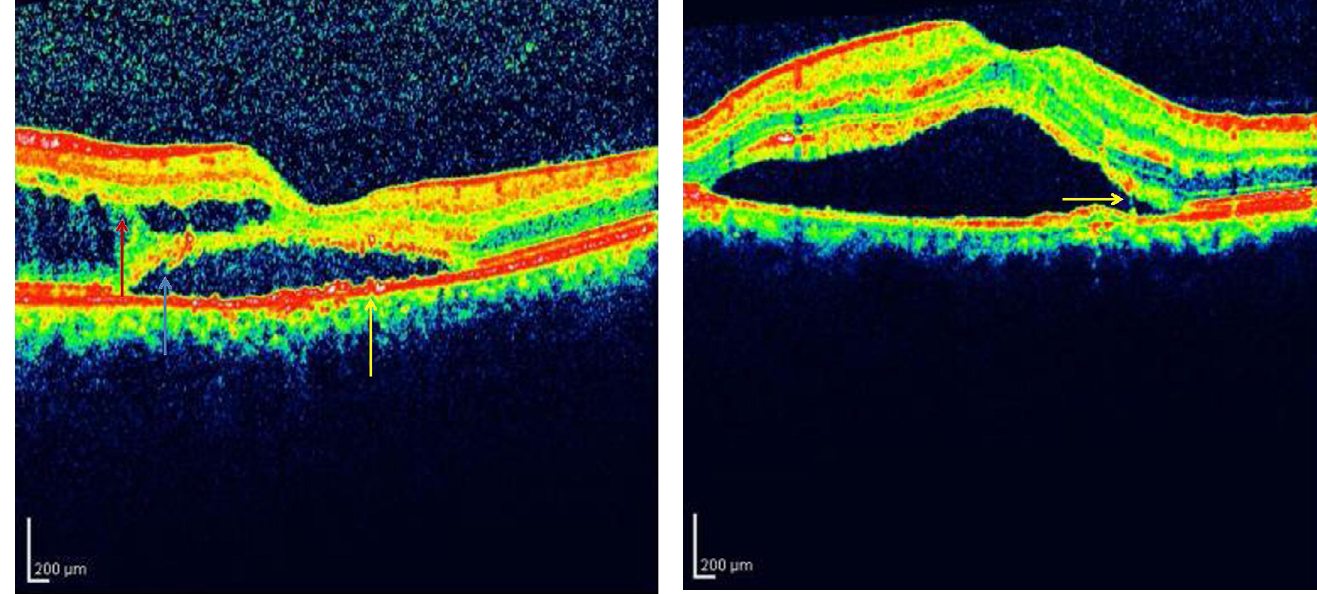
Figure 4: A Spectral OCT image depicting the bridging (yellow arrow) between the neurosensory retina and pigment epithelium in ACSC.